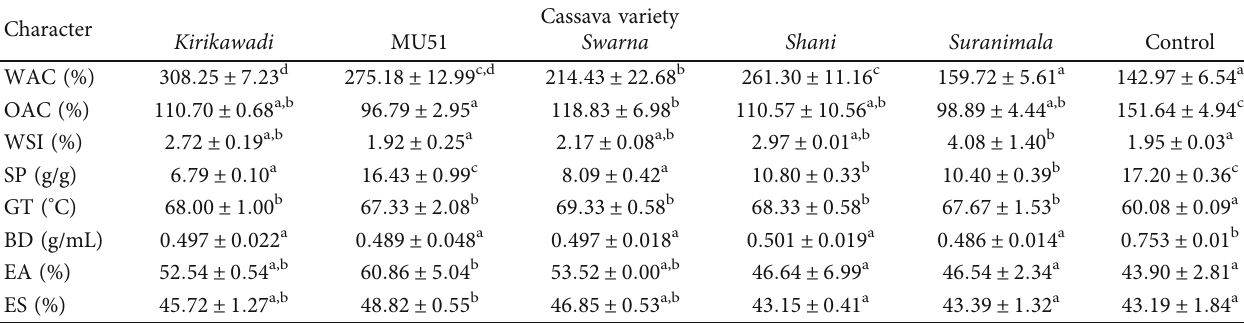
Table 3: Functional properties of cassava fl ours from fi ve Sri Lankan cassava